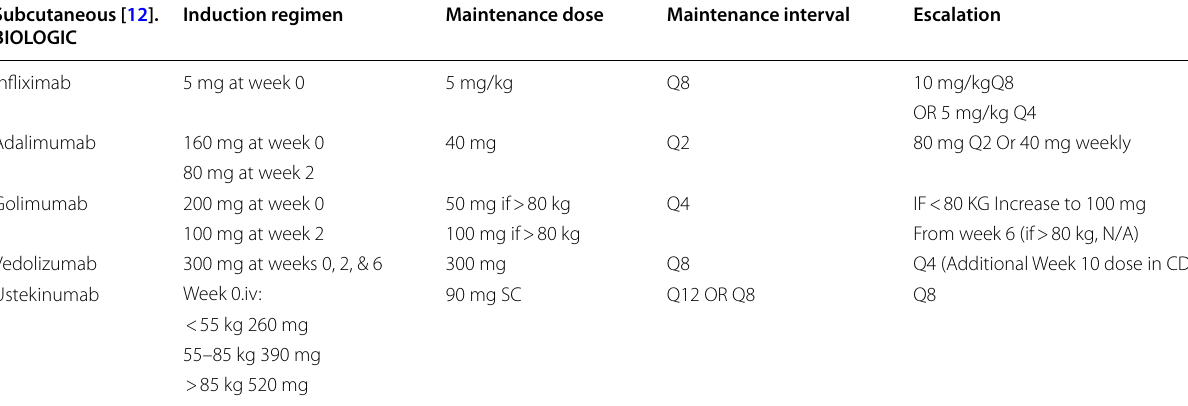
CD Crohn’s disease, IV intravenous; N/A not applicable; SC [62]